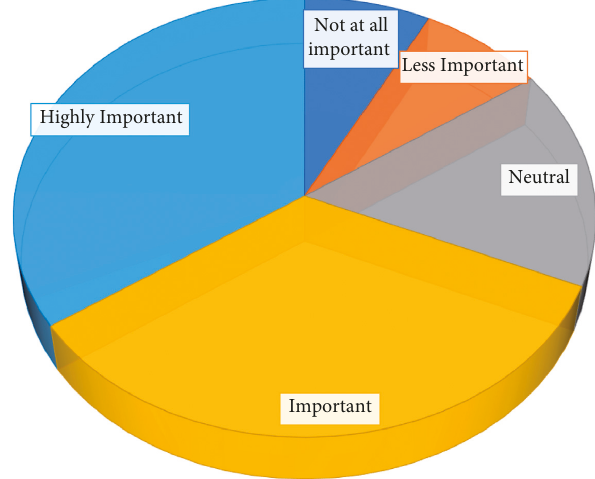
Figure 2: Creating innovative